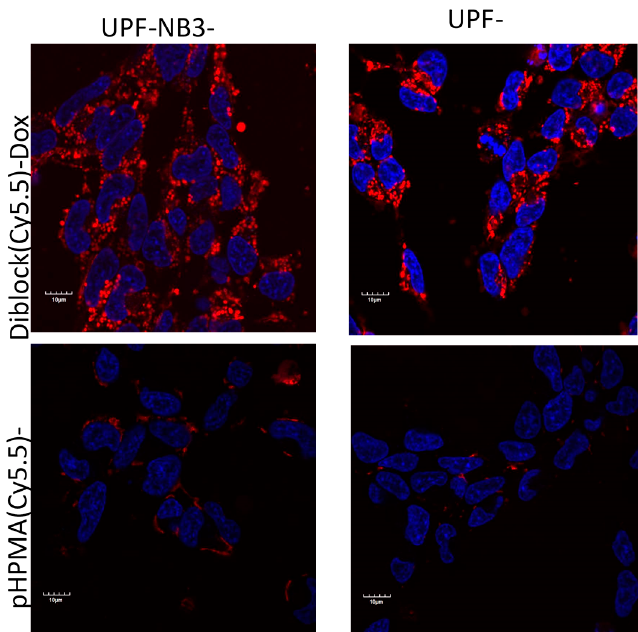
Figure 3. Uptake of polymer conjugates labeled with the fluorescent dye Cyanine 5.5 (shown in red) after incubation of the parental human neuroblastoma UPF-NB3 or resistant UPF-NB3-Dox cell line for 4 h with fluorescently labeled polymer conjugates (micellar PPO-p(HPMA)-(Cy5.5)-Dox (upper row) and linear pHPMA(Cy5.5)-Dox (bottom row)) at 37 °C and 5% CO 2 . The nuclei are stained with Hoechst 33342 (shown in blue). Reprinted with permission from [78], Copyright [2017], Elsevier.